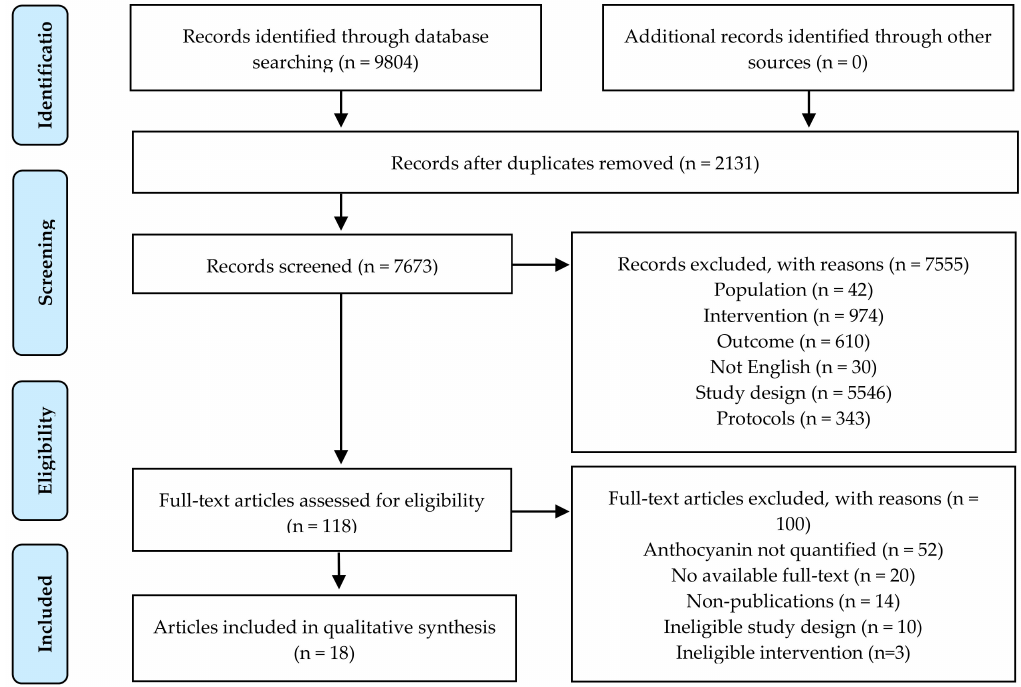
Figure 1. PRISMA flow diagram for the literature search and article